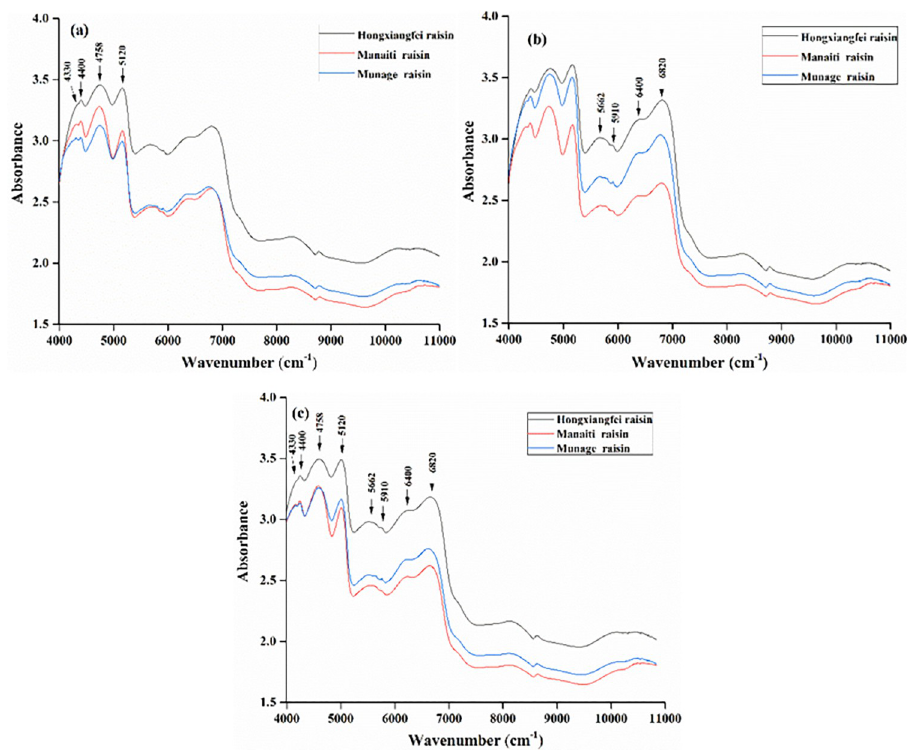
Fig 3. Average raw spectra of a skin, b flesh, and c both of them.